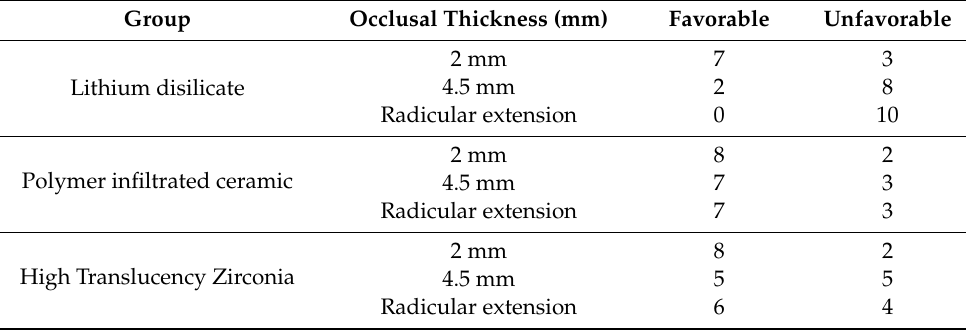
Table 4. Descriptive statistics of the failure modes in di ff erent